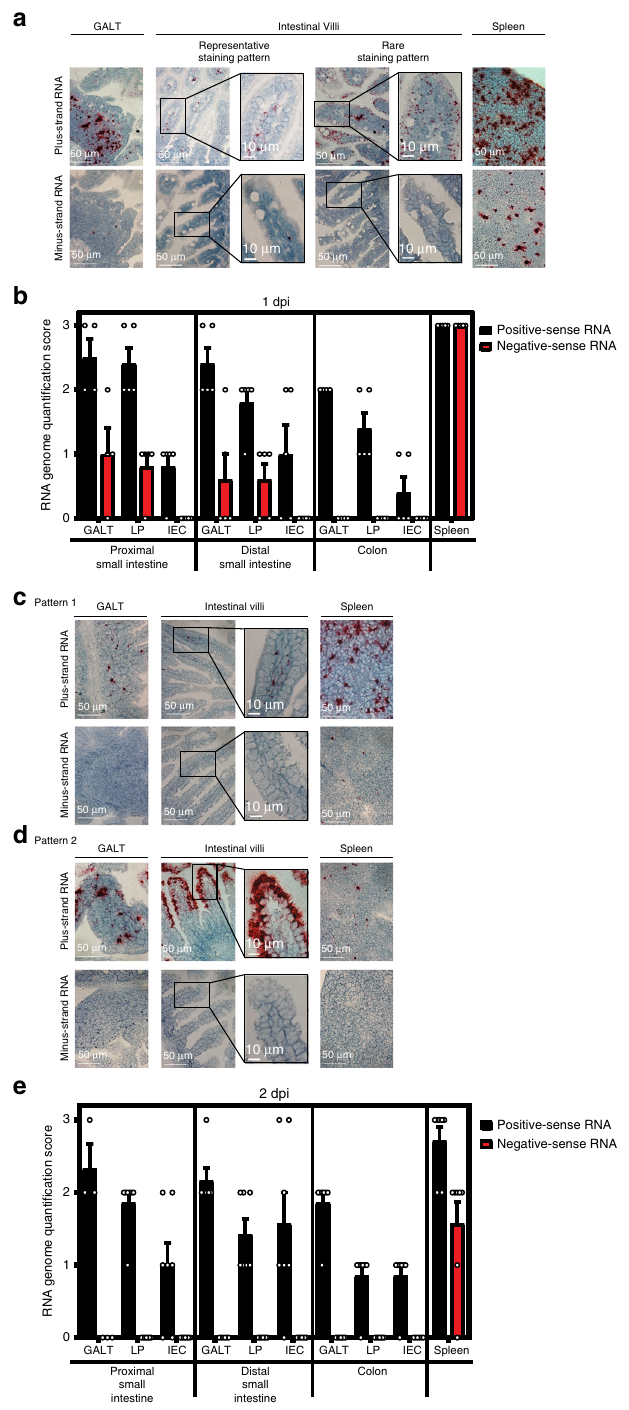
Fig. 5 MNV-1 replicates in intestinal subepithelial cells and splenocytes. Tissue sections from mock-inoculated or MNV-1-infected mice collected at 1 dpi ( a , b ; n = 5 per group) and 2 dpi ( c – e ; n = 7 per group) were probed for viral positive-sense and negative-sense RNA. Representative images of gut-associated lymphoid tissue (GALT), intestinal villi, and splenic tissue are shown for 1 dpi ( a ) and at 2 dpi for 2 distinct patterns ( c , d ). The amount of positive-sense (black) and negative-sense (red) viral RNA detected was scored for each pup, as described in the “ Methods ” at 1 dpi ( b ) and 2 dpi ( e ). Scale bars represent 50 µ m for all images except for insets where they represent 10 µ m. Error bars denote standard errors of mean in all fi gures. Source data are provided as a Source data fi